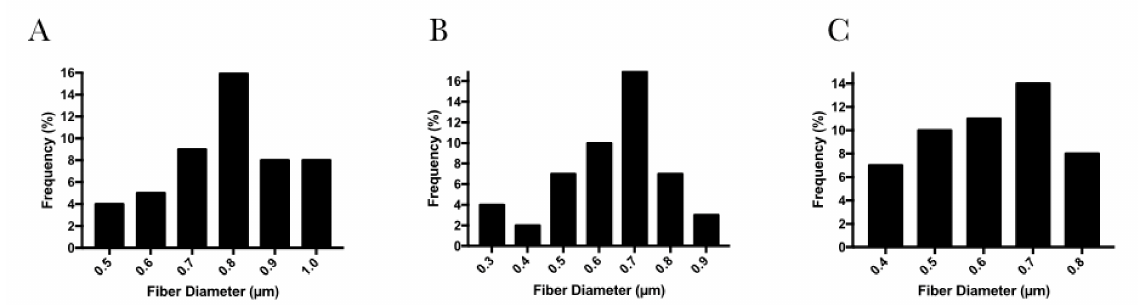
Figure 3. Fiber Diameter Distribution of electrospun membranes. ( A ) Electrospun PLGA loaded with tea tree essential oil, ( B ) Electrospun PLGA loaded with furanone, ( C ) Electrospun pure